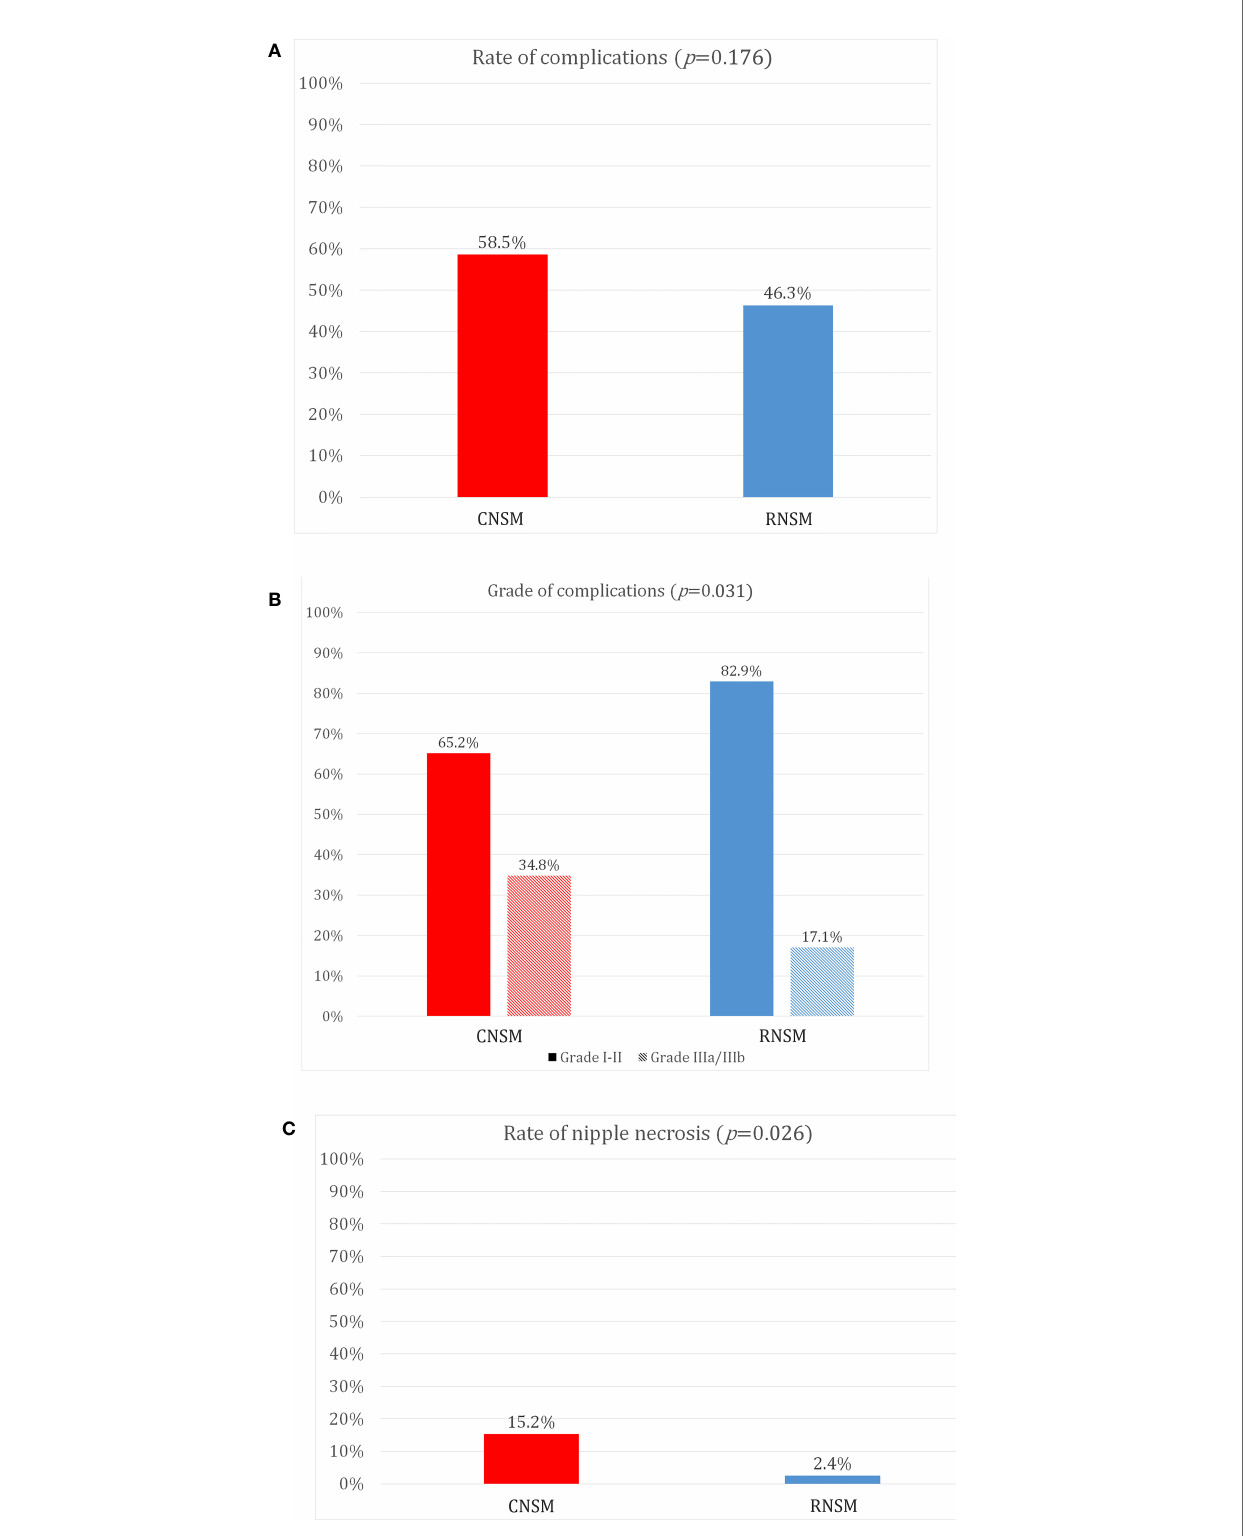
FIGURE 3 | Comparison of post-operative complications between conventional nipple-sparing mastectomy and robot-assisted nipple sparing mastectomy. (A) Rate of complications, (B) Grade of complications, (C) Rate of nipple